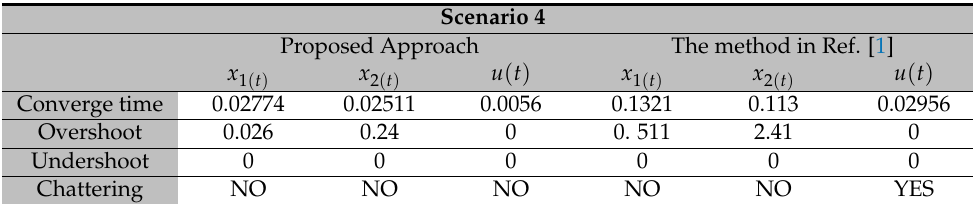
Table 4. Comparing the responses of the DBC system under the conditions of scenario 4. (cid:1)